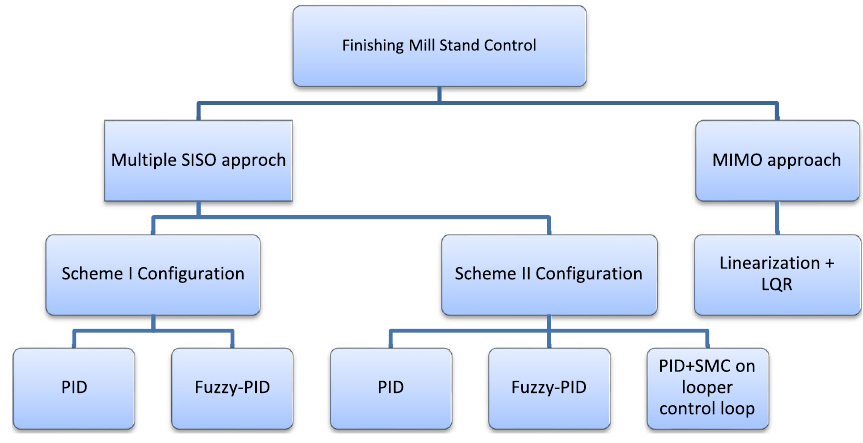
Fig. 4 Control architectures for finishing